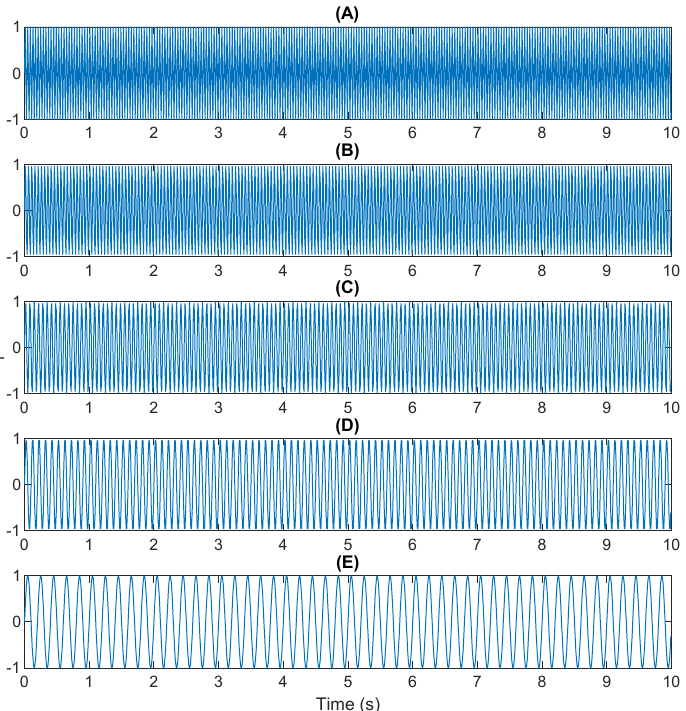
Figure 8. Original sources: ( A ) 25 Hz sin waveform; ( B ) 20 Hz sin waveform; ( C ) 15Hz sin waveform; ( D ) 10 Hz sin waveform; ( E ) 5 Hz sin waveform.